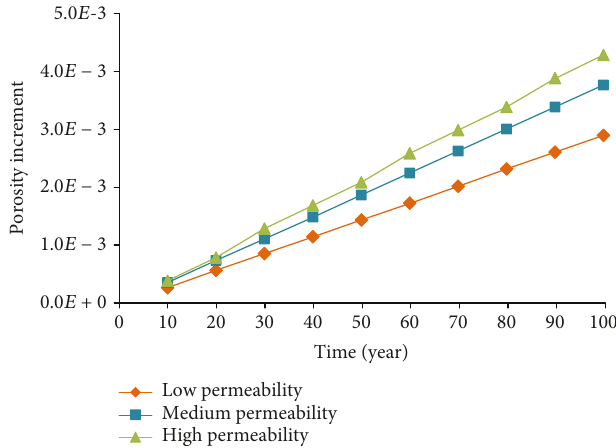
Figure 19: The increase of porosity over